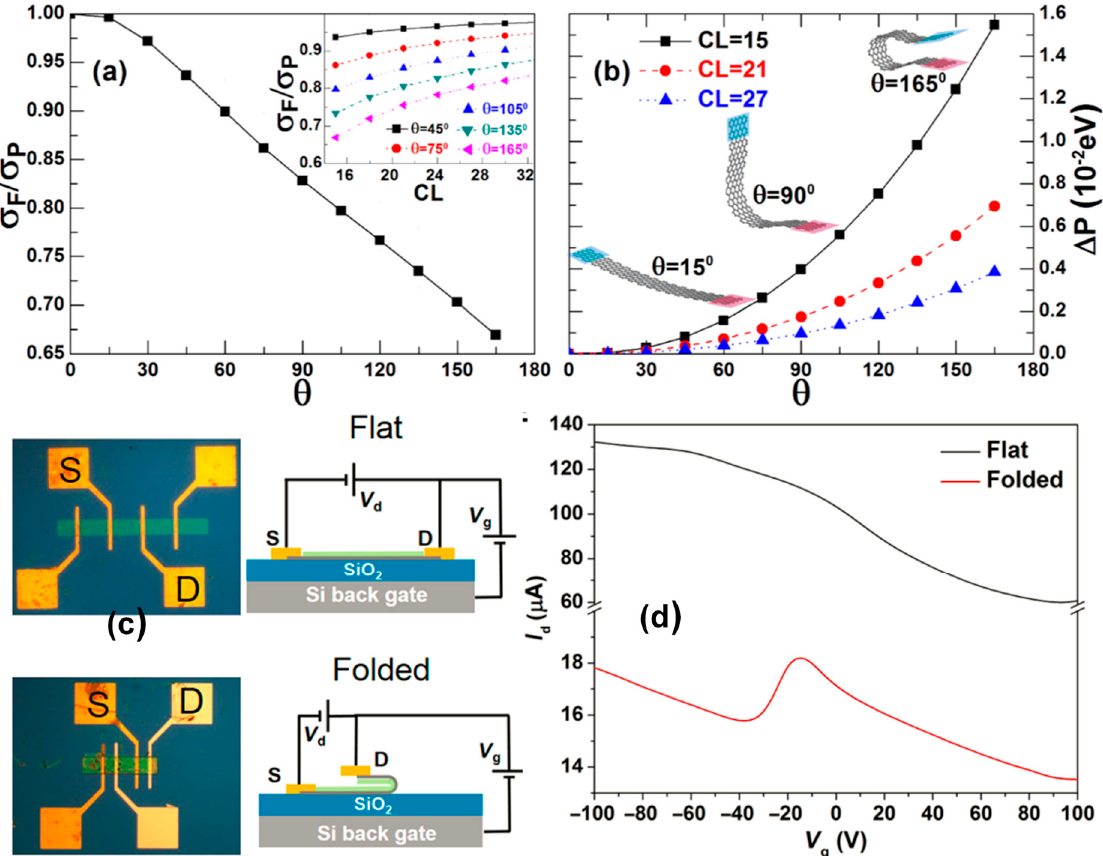
Figure 16. ( a ) σ F / σ P versus θ for the A-FGNR- α with CL(center region length) = 15 at T = 300 K. The inset shows the different θ values belonging to σ F / σ P versus CL [130]. Copyright 2011, American Physical Society. ( b ) The ∆ P versus θ for the A-FGNR- α at different values of CL. ( c ) The optical images and circuit diagrams of graphene field-effect transistors (FETs); flat (top) and folded (bottom). ( d ) The transfer curves of the functionalized graphene FETs as a function of back-gate voltage in the flat (black line) and folded (red line) states [131]. Copyright 2017, Science.